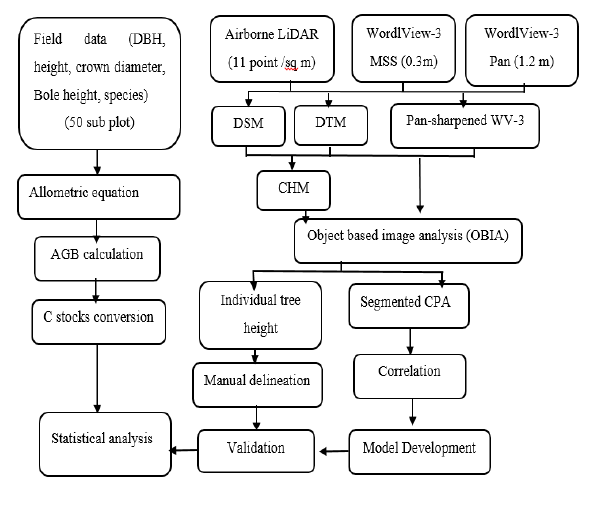
Figure 3. Methodology